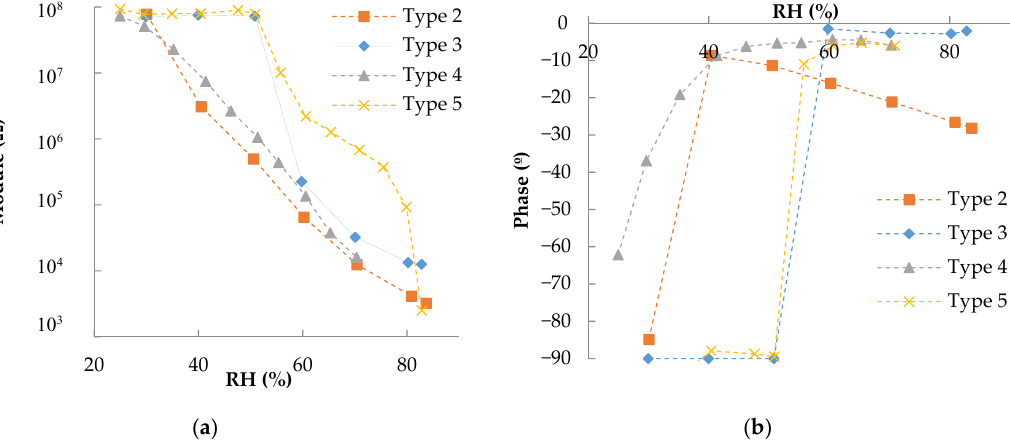
Figure 3. Impedance response towards RH at 100 Hz and 40 °C for the different deposited layers with distance between consecutive fingers of 300 µm: ( a ) module and ( b ) phase.